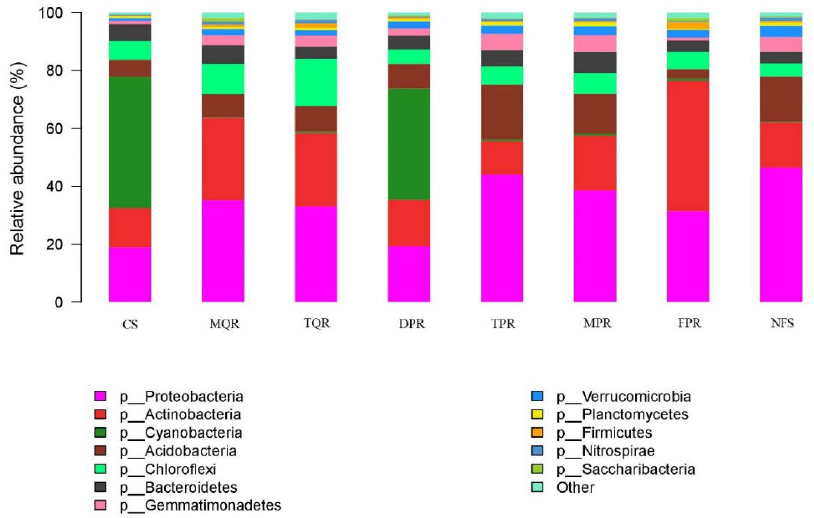
Figure 1. Distribution of 16S rRNA sequences across bacterial communities. CS, control soil; MPR, middle portion of Pinus tabuliformis roots; TPR, tips of P. tabuliformis roots; MQR, middle portion of Quercus variabilis roots; tips of Q. variabilis roots; FPR, post-fire planted forest of P. tabuliformis ; DPR, dead P. tabuliformis roots; NFS, natural P. tabuliformis forest.